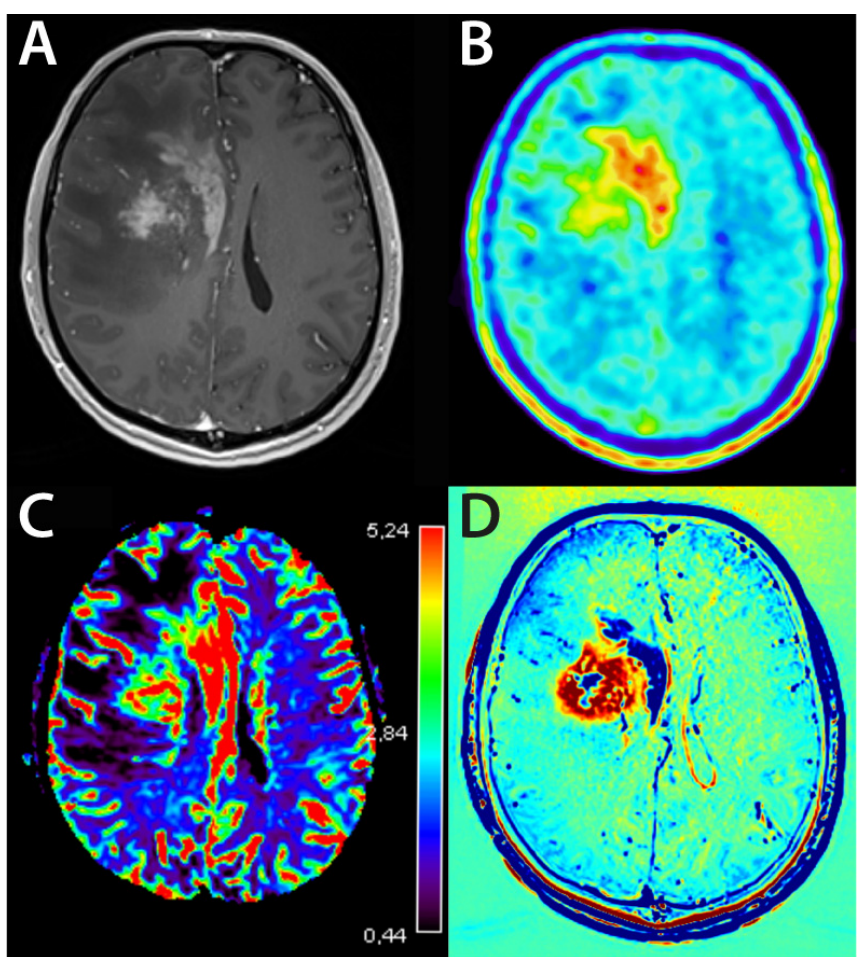
Figure 4. Example of both radiation necrosis and tumor progression in a case of glioblastoma after radiochemotherapy. ( A ): structural MRI, ( B ): FET-PET, ( C ): perfusion-weighted MRI, ( D ): delayed contrast MRI.